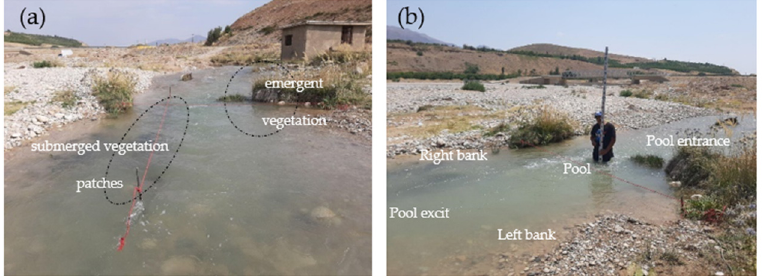
Figure 1. ( a ) Location of the selected reach in the Padena Marbor River; ( b ) topographic surveying.